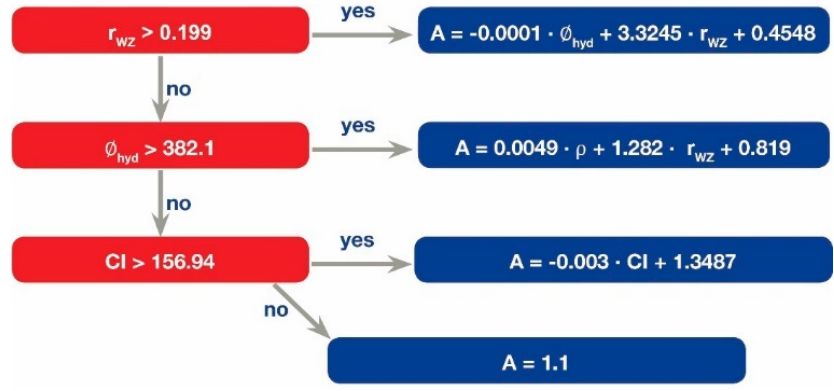
Figure 3. M5P regression tree. Table 1. List of descriptors and their relative importance (RI, %) in quantitative structure–activity relationship (QSAR) model. LDM: “liquid drop” model.